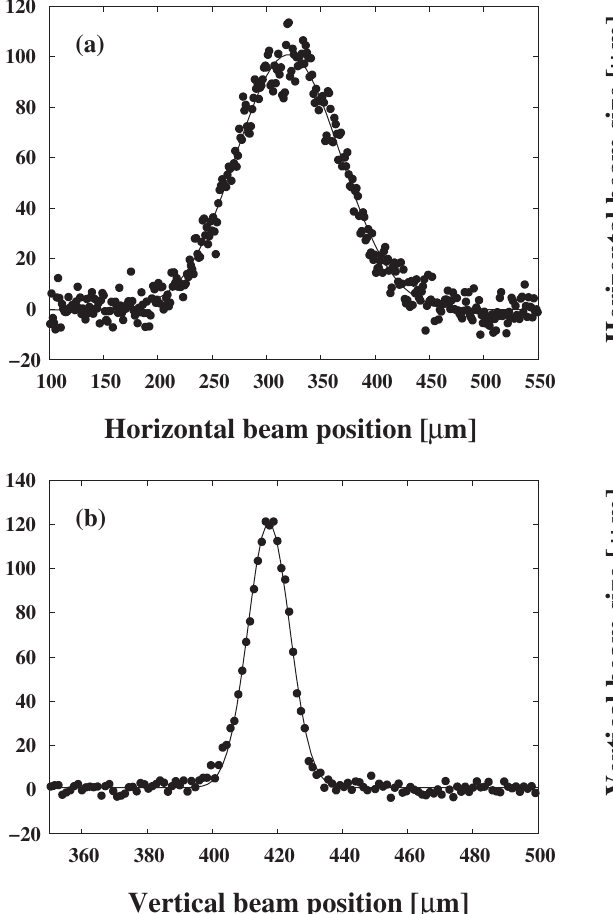
FIG. 11. Sample of (a) horizontal and (b) vertical beam pro- files with their fitted Gaussian curves. The shutter opening time was fixed to 1 ms. Data are from 2005 = 6 = 1 .